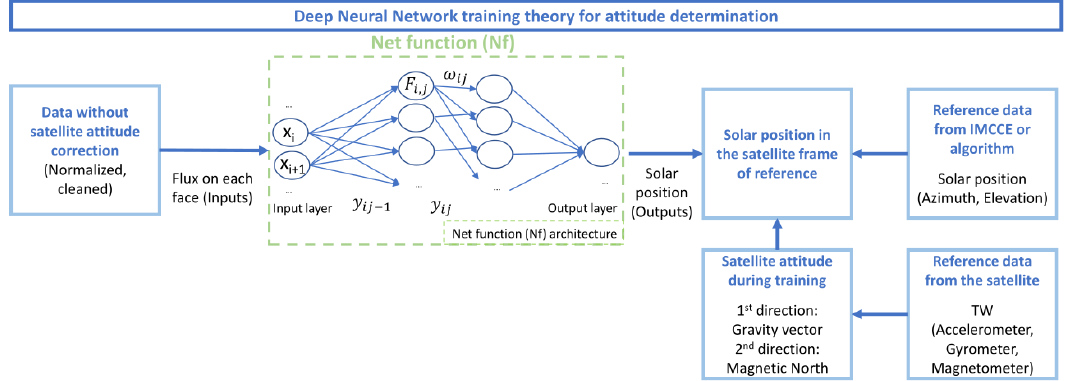
Figure 4. Neural Network architecture with fully connected layers, as well as the inputs and outputs.